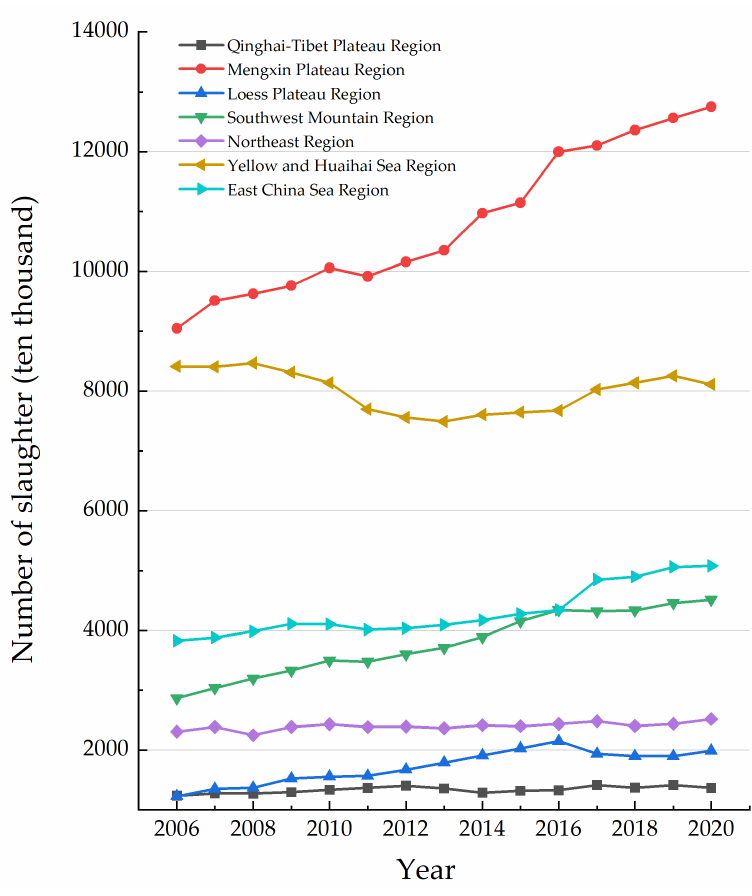
Figure 4. The amount of cattle and sheep slaughtered in each livestock